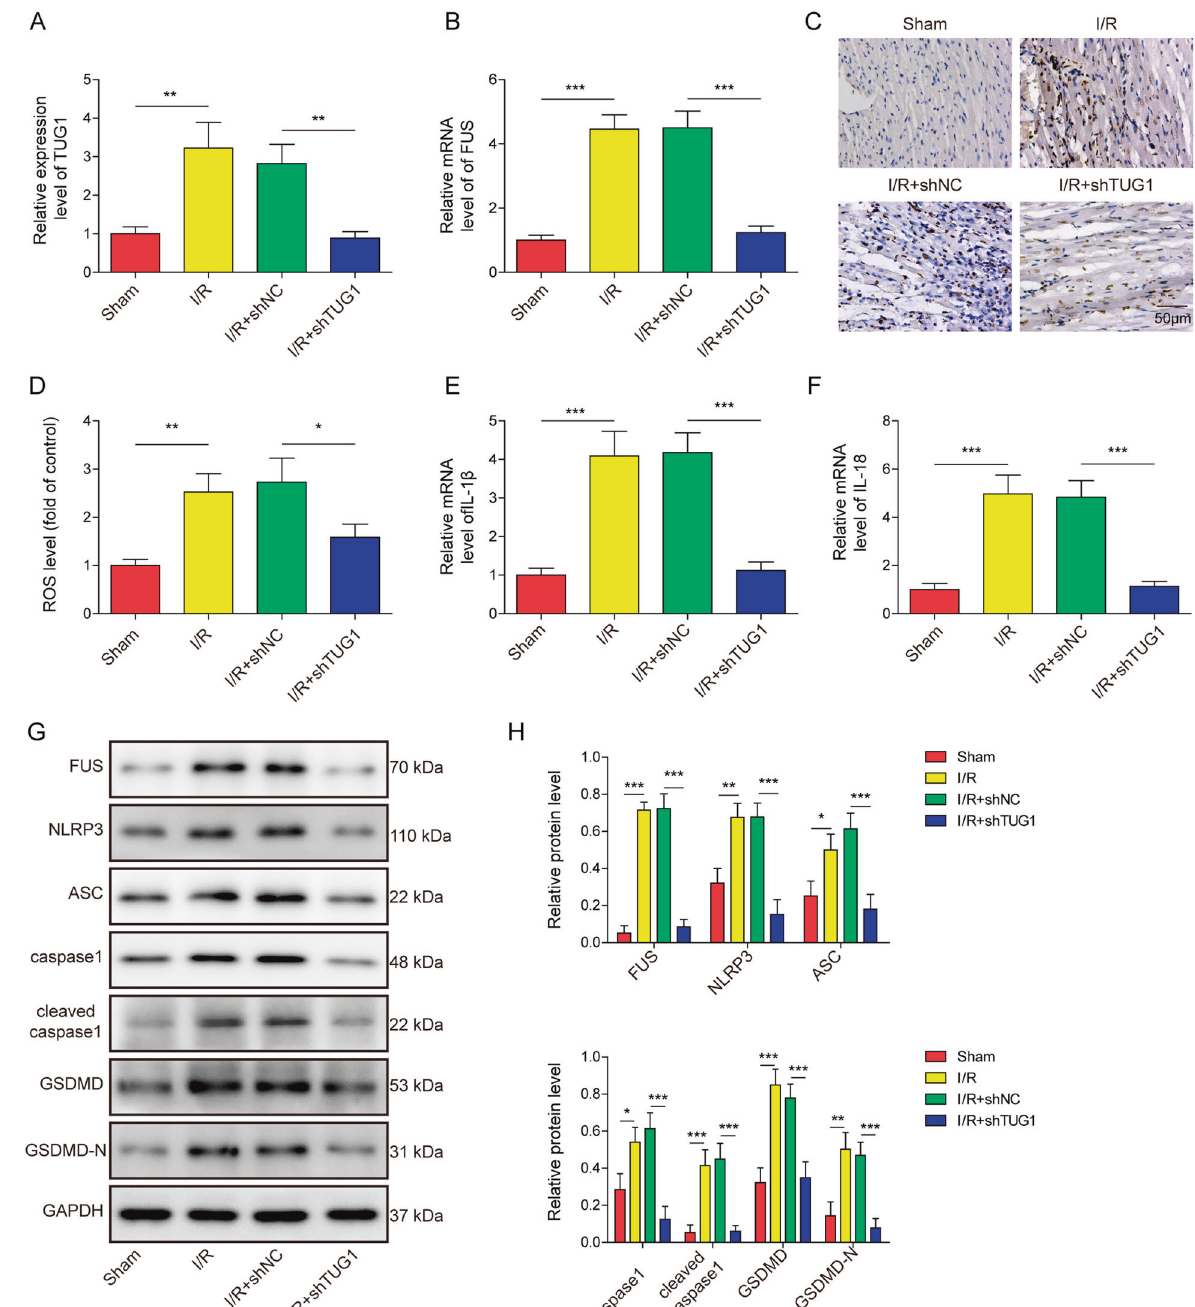
Fig. 8 Silencing TUG1 reduced FUS expression and FUS-induced mitochondrial dysfunction and pyroptosis in a mouse model. The expression of A TUG1 and B FUS was measured using qRT-PCR in the myocardial tissue of I/R mice. C FUS expression in myocardial tissue was stained using immunohistochemistry. D ROS levels were measured using a DHE assay. The mRNA expression of E IL-1 β and F IL-18 was measured using qRT-PCR. G , H The protein levels of FUS, NLRP3, ASC, and other downstream pyroptosis-related factors were measured using western blotting. * P < 0.05, ** P < 0.01 and *** P <